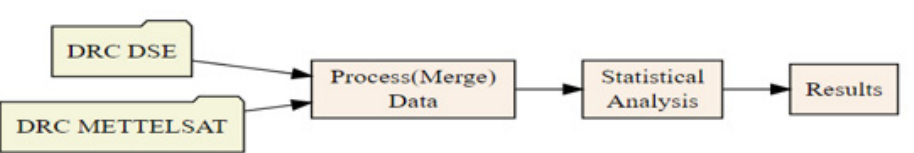
Figure 2. Data collection flow chart. DRC METTELSAT; National Agency of Meteorology and Re- mote Sensing by Satellite of the DRC. DRC DSE: Epidemiological Surveillance Directorate of the DRC.